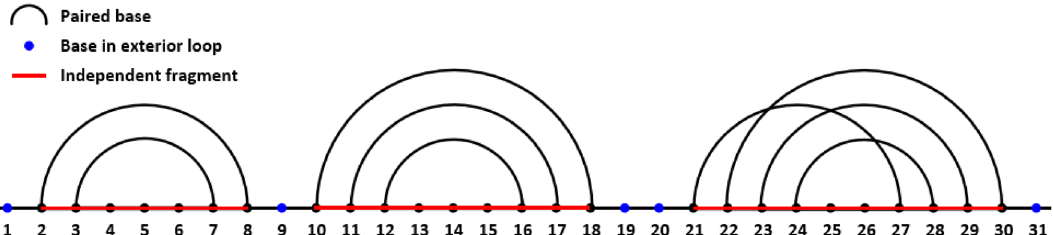
Figure 1. Exterior loop and i-fragment. Each dot (black or blue) in the line represents a base, and the two dots connected by an arc are paired bases. The blue dots stand for the bases in exterior loops. The red lines represent the